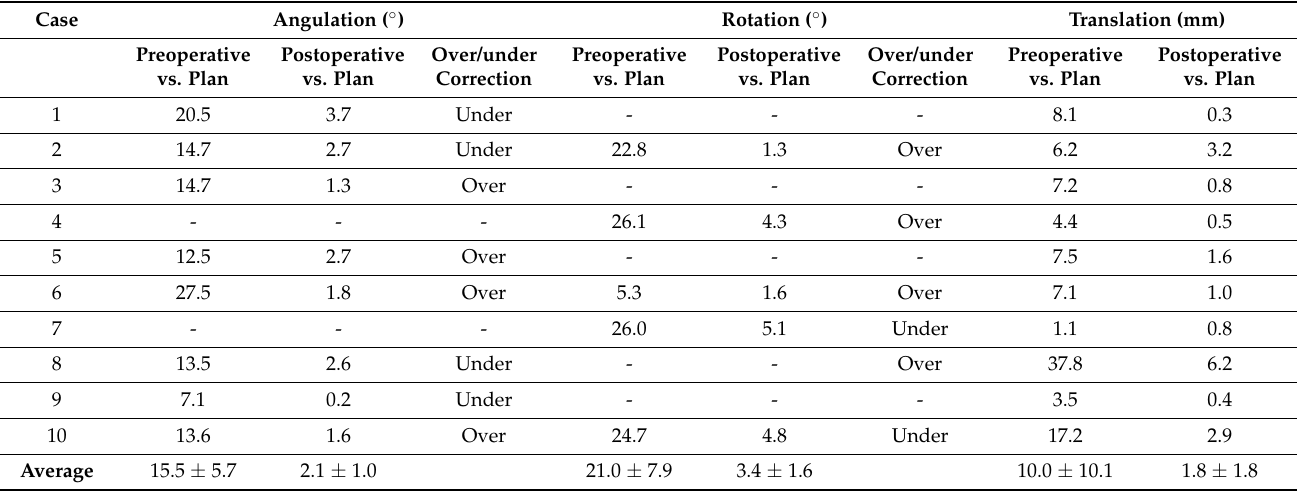
Table 2. Postoperative evaluation of the performed corrective osteotomies. Accuracy was assessed in terms of angulation (degrees), rotation (degrees) and translation